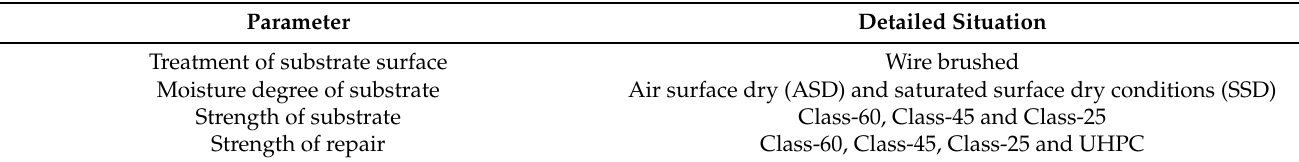
Table 3. Studied parameters used in the tests.